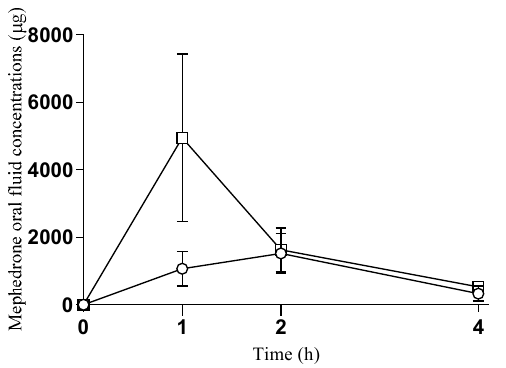
Figure 2. Time-course of mephedrone oral fluid concentrations after oral and intranasal self-ad- ministration ( ○ oral mephedrone ( n = 5); □ intranasal mephedrone ( n = 5)).